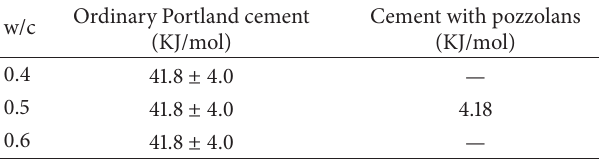
Table 1: Activation energies for various cement